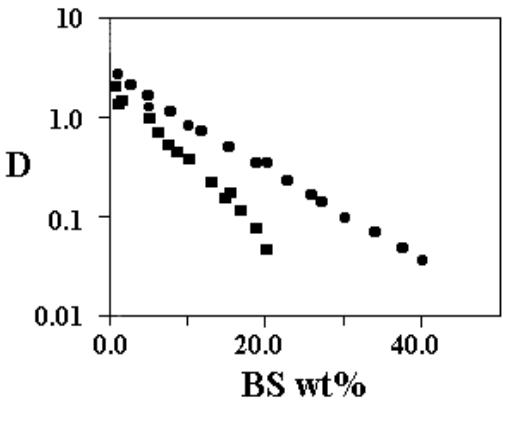
Figure 4. Surfactant self-diffusion, D , in 10 circles, and NaTDC , squares, at 25.0 °C. Data are in semi-logarithmic scale. They refer to the region of existence of the solution phase. Note the significant differences between NaTC and NaTDC